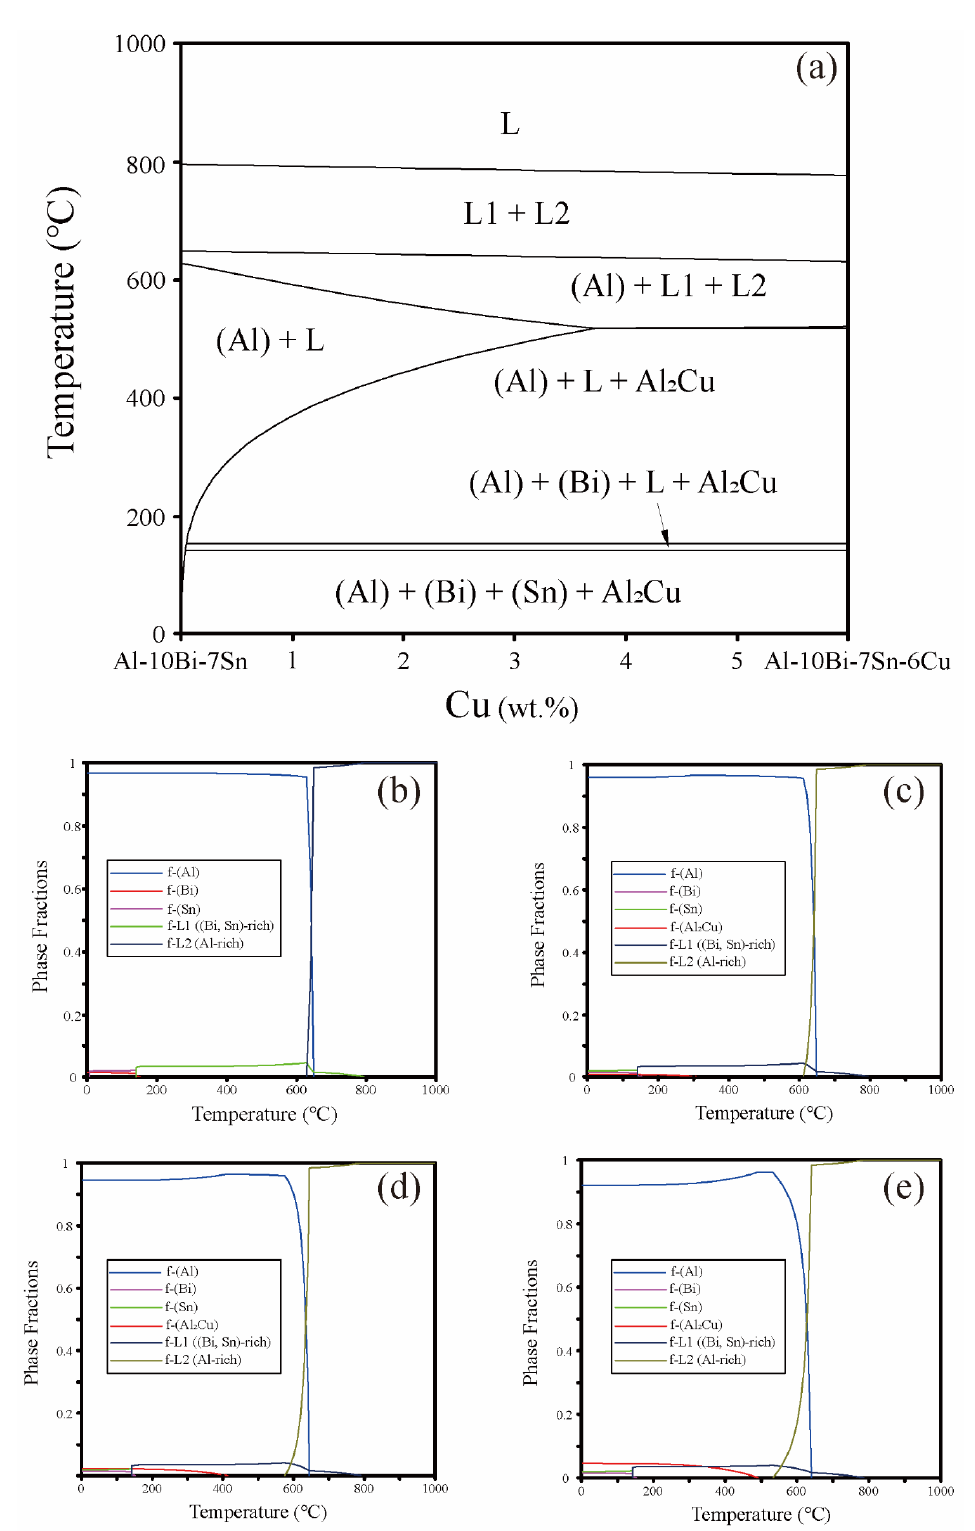
Figure 1. ( a ) Calculated vertical phase diagram of Al–10Bi–7Sn-(0~6)Cu wt%, and calculated phase fractions during solidification in ( b ) Al–10Bi–7Sn, ( c ) Al–10Bi–7Sn–0.5Cu, ( d ) Al–10Bi–7Sn–1.5Cu, (e) Al–10Bi–7Sn–3Cu alloys.